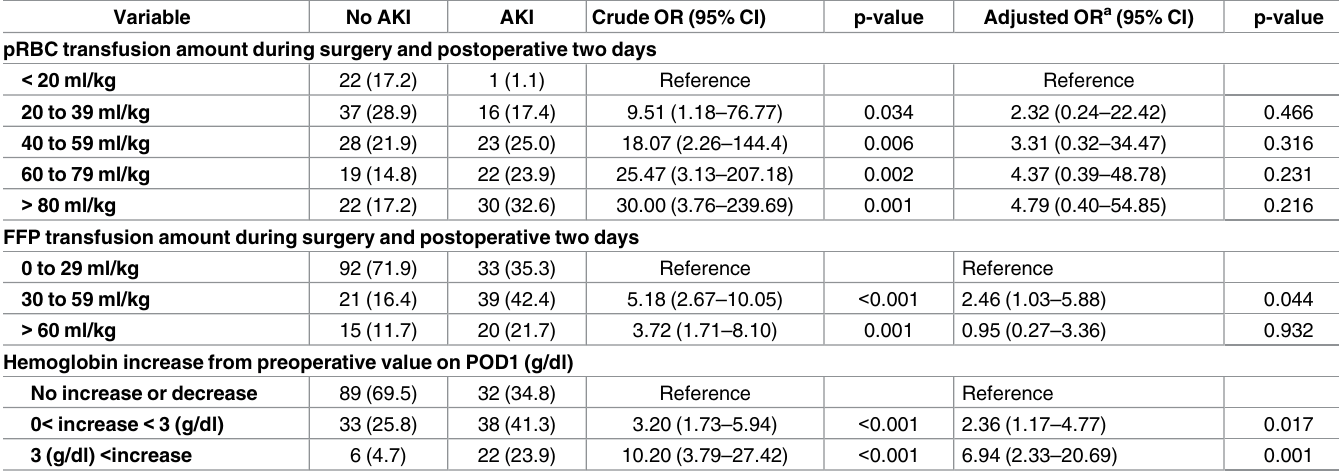
Table 4. Association between intraoperativetransfusion amount and postoperative acute kidney injury.